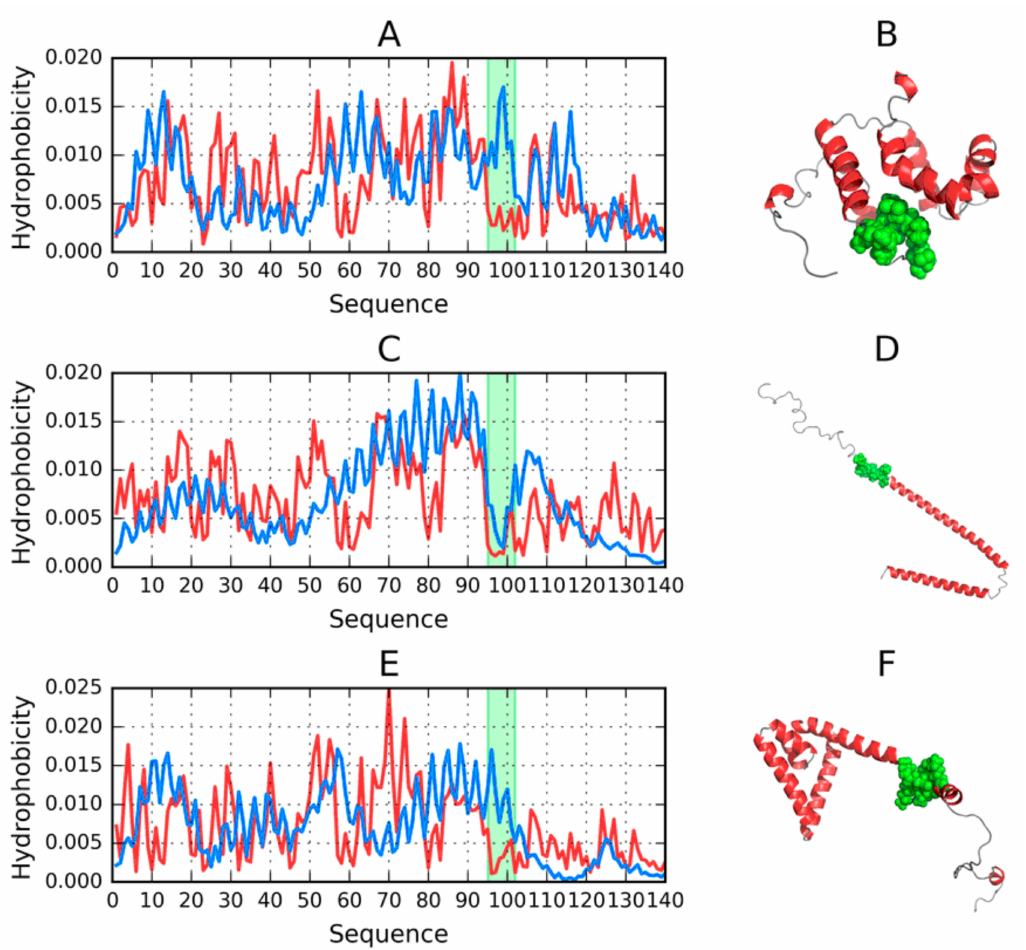
Figure 5. 3D visualizations along with theoretical (T, blue) and observed (O, red) hydrophobicity density distribution profiles for models of the 1–140 fragment produced by each software package and characterized by the lowest RD. The 95–102 fragment is highlighted in green; ( A , B )—FOD_1_(202); ( C , D )—ITASSER_1_(1); ( E , F